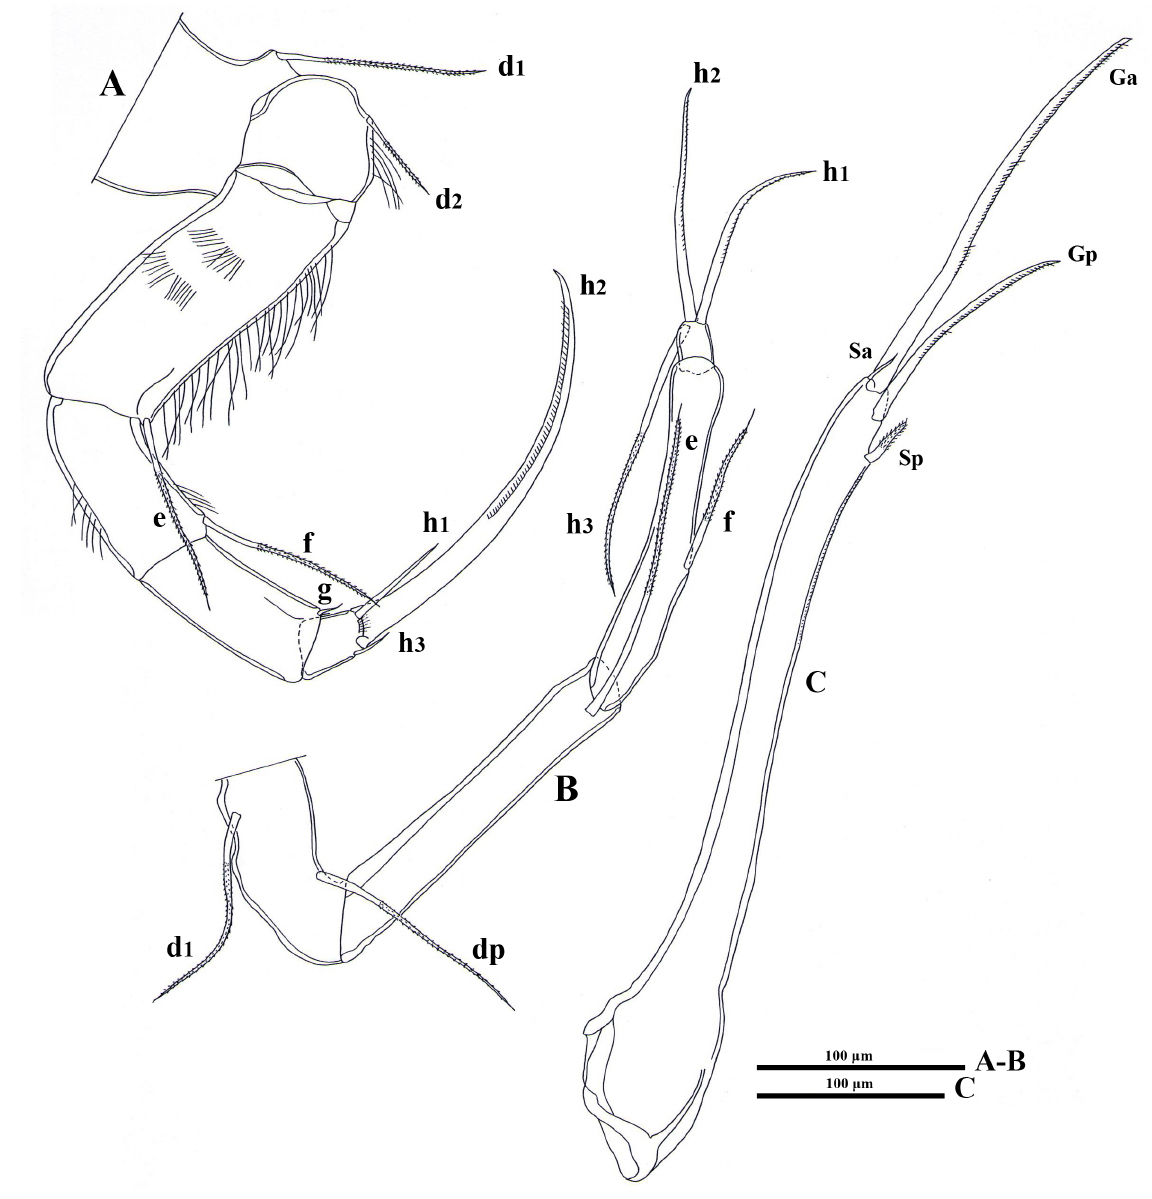
Fig. 8. Martensina thailandica gen. et sp. nov., allotype, ♀ (MSU-ZOC.318). A . T2. B . T3. C . CR. Scale bars = 100